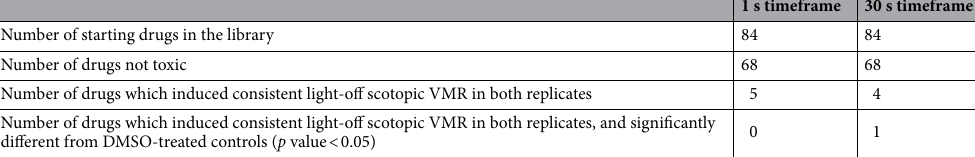
per second for the duration of the experiment. When exposed to a light intensity of 0.01 lx, wild-type (WT) larvae displayed a robust startle response immediately after light offset (light-off VMR), while Q344X larvae dis- played a significantly diminished light-off VMR (Fig. 1b). Specifically, WT larvae traveled significantly further on average than the Q344X larvae ( µ ± standard error of the mean ( s.e.m ): 0.281 ± 0.036 cm vs. 0.127 ± 0.031 cm) one second after light offset (Fig. 1c). Both Q344X and WT larvae did not show a response to the light onset at 0.01 lx, and both groups displayed a similar VMR at higher photopic intensities (Supplementary Fig. S2). These results indicate that the expression of Q344X RHO diminished the light-off VMR of Q344X larvae at 0.01 lx. The diminished VMR of Q344X larvae was likely caused by rod degeneration. We confirmed rods were